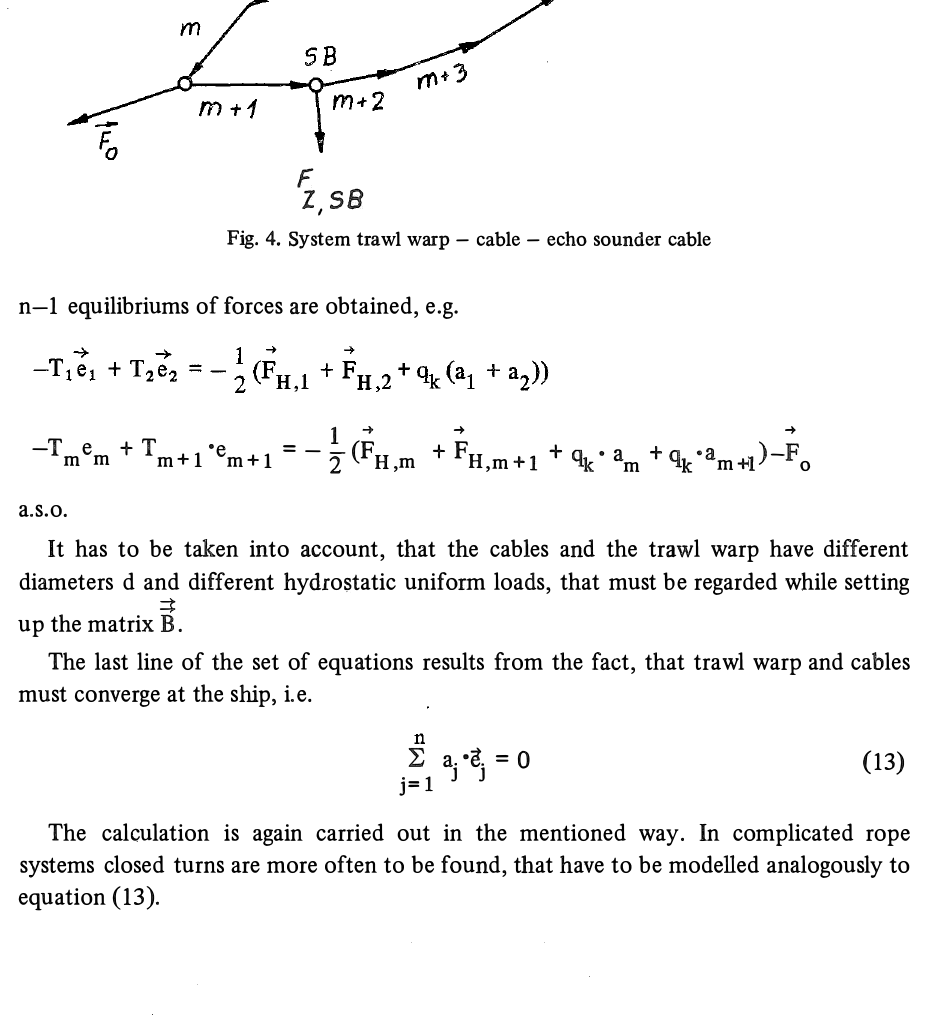
Fig. 4. System trawl warp -cable -echo sounder